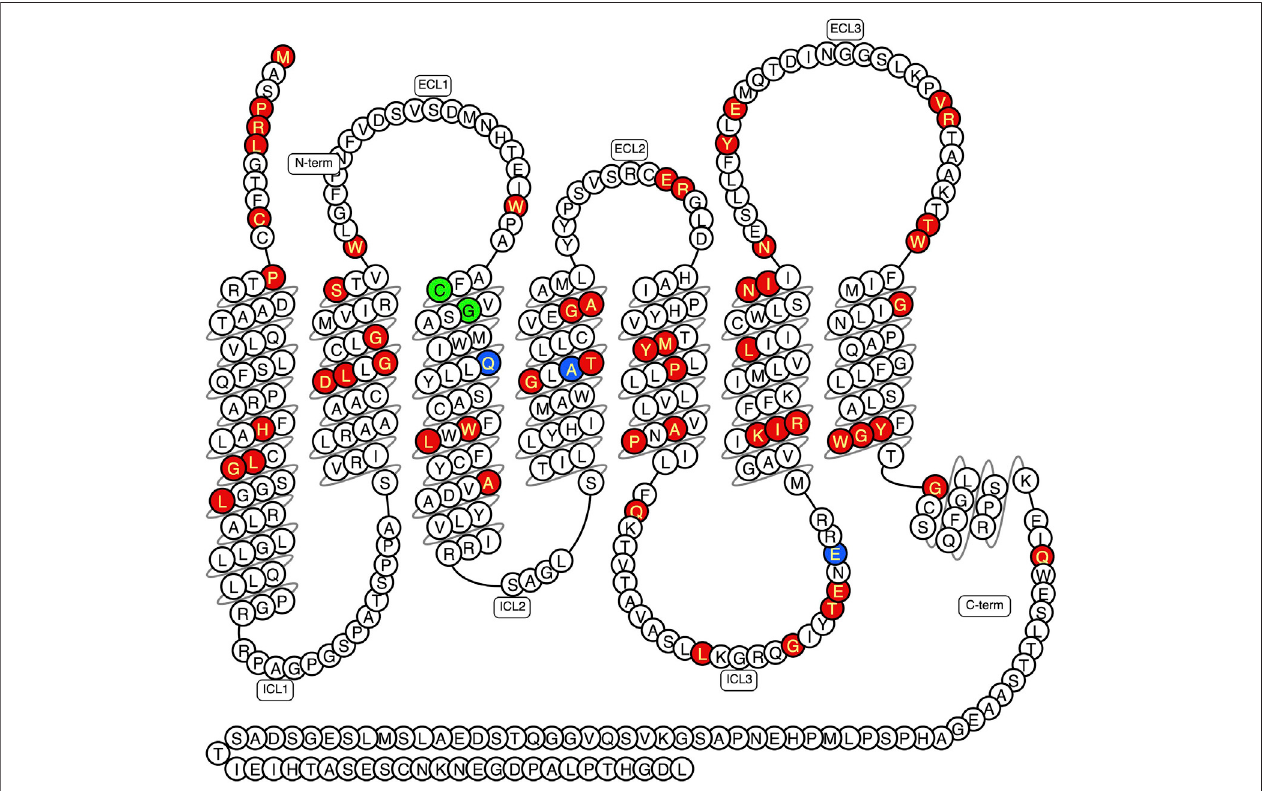
FIGURE 2 | Proteinsequence ofGPR143 showing pathogenetic point mutations which lead tothe OA1 phenotype (red) and mutations which cause a mild variant of OA1(blue).Forsomemutatedaminoacids,eitherstrongorweakOA1phenotypeswerereported(green).ThesnakeplotwascreatedusingGPCRdb(Kooistraetal.,2021).